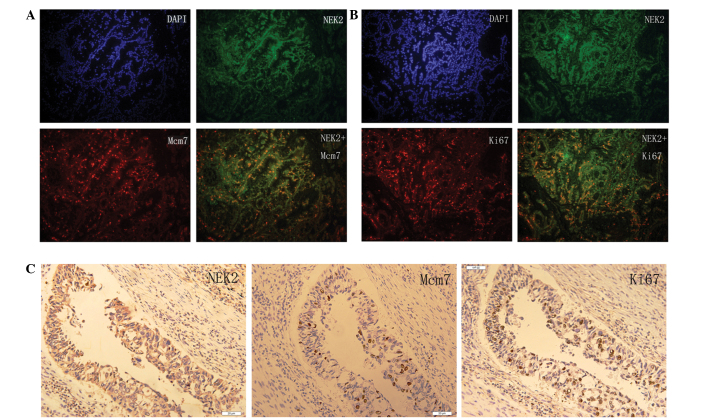
Immunoco-localization and co-expression images of NEK2 and Mcm7/Ki67 in NSCLC. (A) The co-localization of NEK2 and Mcm7 in well-differentiated lung ADC. (B) The co-localization of NEK2 and Ki67 in poorly-differentiated lung SCC. NEK2-positive staining was present in the cytoplasm and Mcm7/Ki67 in the nucleus. The coexistence regions were present in the majority of NEK2-positive NSCLC cells. (C) The co-expression of NEK2 and Mcm7/Ki67 in moderately-differentiated lung ADC (bar, 20 μm). NEK2, never in mitosis gene A (NIMA)-related kinase 2; mcm7, minichromosome maintenance complex component 7; NSCLC, non-small cell lung cancer; SSC, squamous cell carcinoma; ADC, adenocarcinoma.